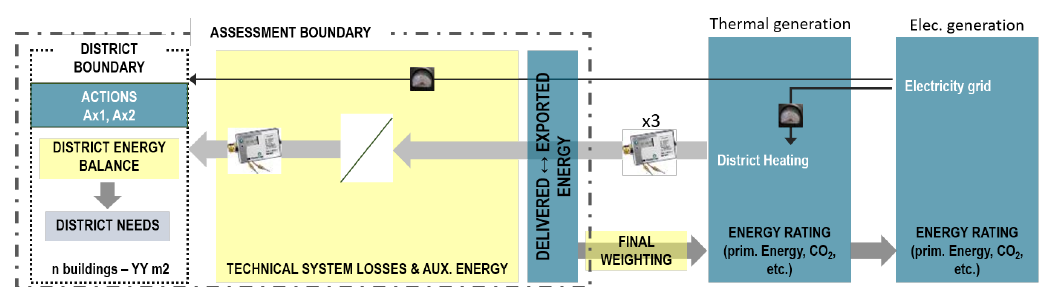
Figure 3. Monitoring template schema for energy monitoring in cities.